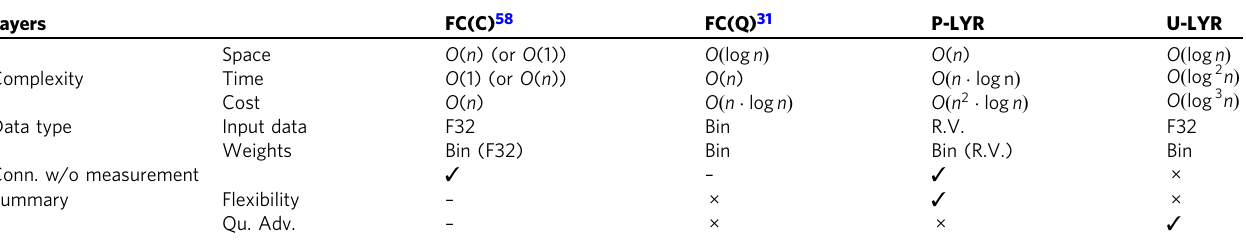
Table 1 Comparison of the implementation of a basic neural computation with n input neurons and 1 output neuron.